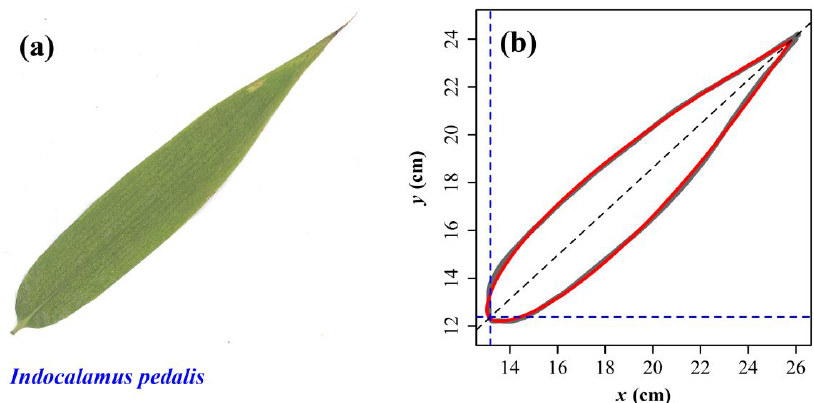
Figure 1. A leaf of one bamboo plant and fitted results using the simplified Gielis equation (SGE). ( a ) Scanned leaf image; ( b ) Observed and predicted leaf edge. The gray curve represents the scanned (observed) leaf edge, and the red curve represents the leaf edge predicted by the SGE.